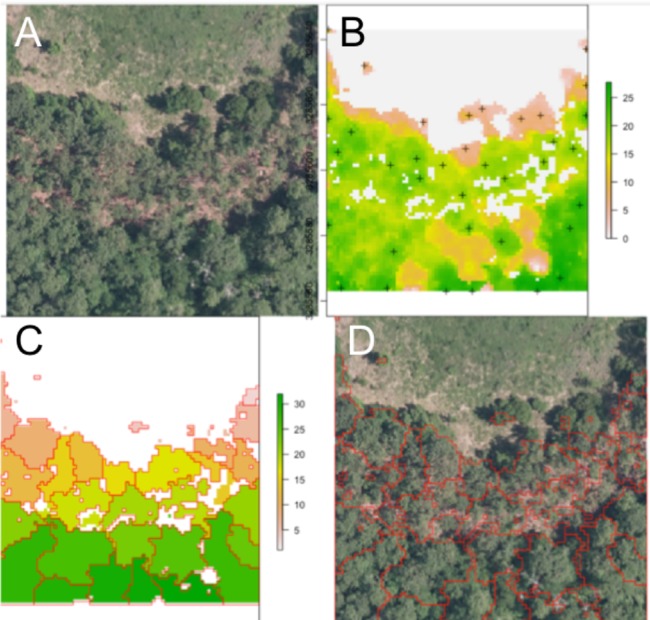
Segmentation results for one plot.(A) Raw RGB image of the plot scene. (B) Canopy height model of the scene, filtered to exclude points with NDVI <0.5 and height <3 m. Local maxima associated with presumptive treetops are shown in black marks. (C) Output of the watershed segmentation routine showing polygonal crowns. (D) Crown segmentations overlaid in red on the input RGB image. All RGB color imagery was created by NEON and is directly available within the dataset used in the competition (National Ecological Observatory Network, 2016). NEON’s data use policy allows for the free use and publication of all data contained within these datasets provided that credit is attributed.